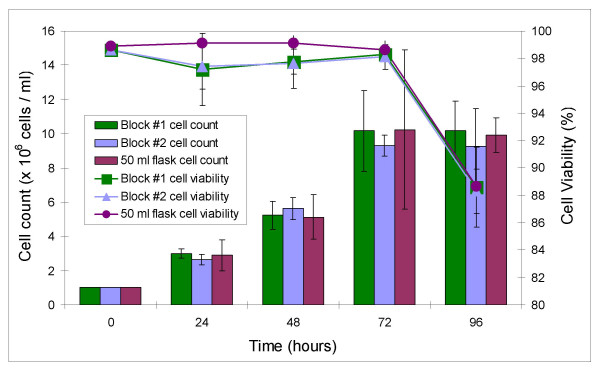
Comparison of HEK-293E growth kinetics in 24 well blocks culture and 50 ml flask culture. Cells were seeded at 1 × 106 cells/ml in either a total of 50 ml (flask) or 2 ml (24 well blocks). Two separate 24 well blocks were analysed alongside one large scale flask culture in triplicate. Cells were counted using a Neubauer haemocytometer to calculate cell growth and cell viability. Error bars represent standard deviations calculated from the data (n = 3).